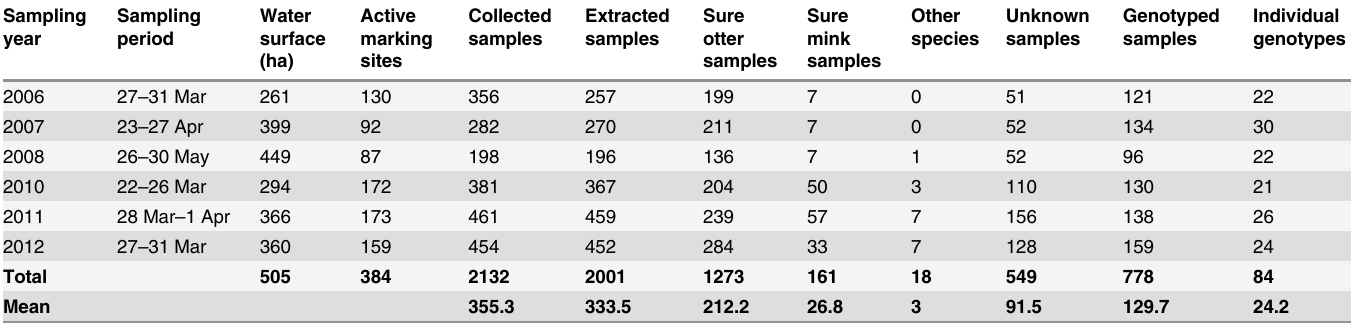
Table 1. Results of faecal-based genetic CMR samplings (2006 – 2012) from a wild otter population living in pond areas in Upper Lusatia (Saxony, Germany).